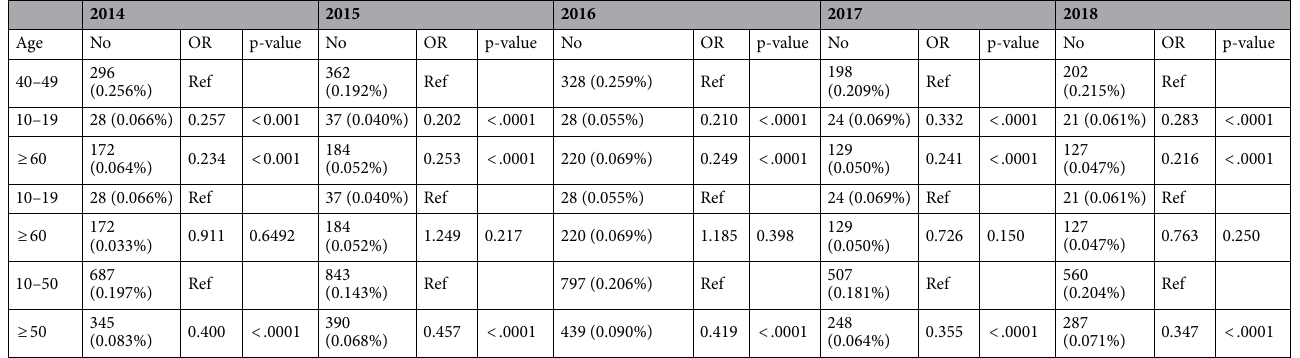
Table 5. Age-standardized prevalence rate stratified by age from 2014 to 2018. OR odds ratio, CI confidence